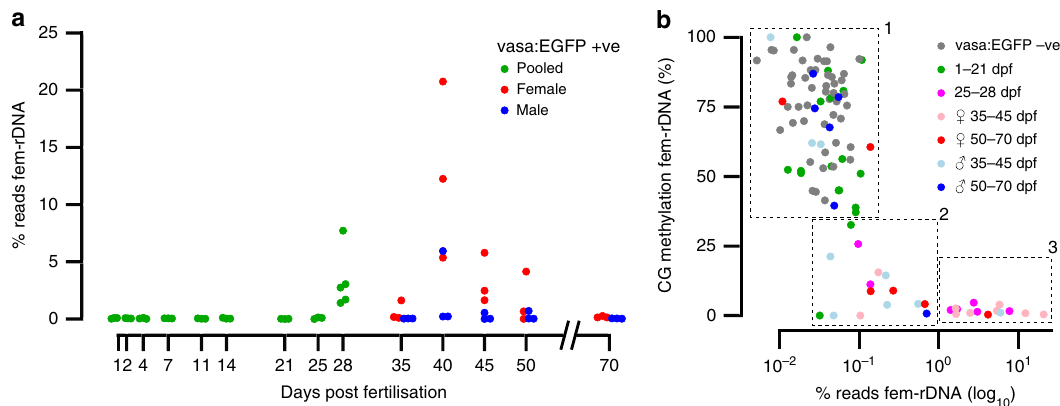
Fig. 4 Ampli fi cation and methylation of oocyte-speci fi c fem-rDNA during gonad transformation. a Percentage of reads mapping to fem-rDNA in the germline prior to sexual differentiation (green), and in presumptive males (blue) and females (red) during gonad transformation and after sexual maturation. b Relationship between the ampli fi cation and methylation of fem-rDNA for vasa:EGFP − ve control samples (grey dots), and vasa:EGFP + ve germline cells from sexually undifferentiated fi sh at 1 – 21 (green dots) and 25 – 28 dpf (magenta dots); presumptive female fi sh at 35 – 45 (pink) and 50 – 70 (red) dpf; presumptive male fi sh at 35 – 45 (light blue) and 50 – 70 (blue) dpf. Samples have been divided into 3 clusters based on rDNA level and methylation; (1) ‘ background ’ non-ampli fi ed and methylated (2) moderately ampli fi ed and lowly methylated, (3) highly ampli fi ed and unmethylated. These consist of n = 75, n = 15, and n = 14 samples,